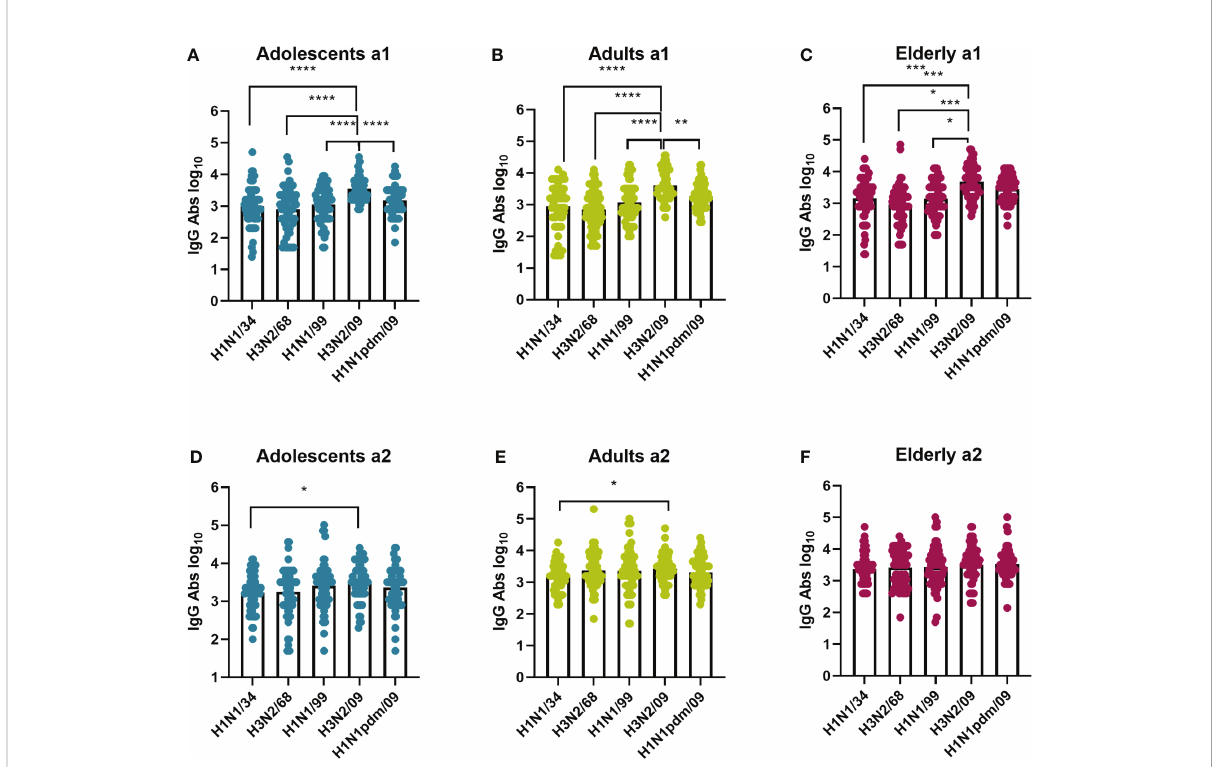
FIGURE 4 In fl uenza virus strain-related differences in IgG antibodies titers per age cohort. The sera from adolescents (A, D) , adults (B, E) , and elderly (C, F) taken at a1 and a2 were assessed by ELISA for total IgG antibodies against the same virus strains as in Figure 2, indicated on the X axis. Data were analyzed using Friedman test followed by Dunn ’ s post-hoc test for multiple comparison. *P ≤ 0.05; **P ≤ 0.01; ***P ≤ 0.001; ****P ≤